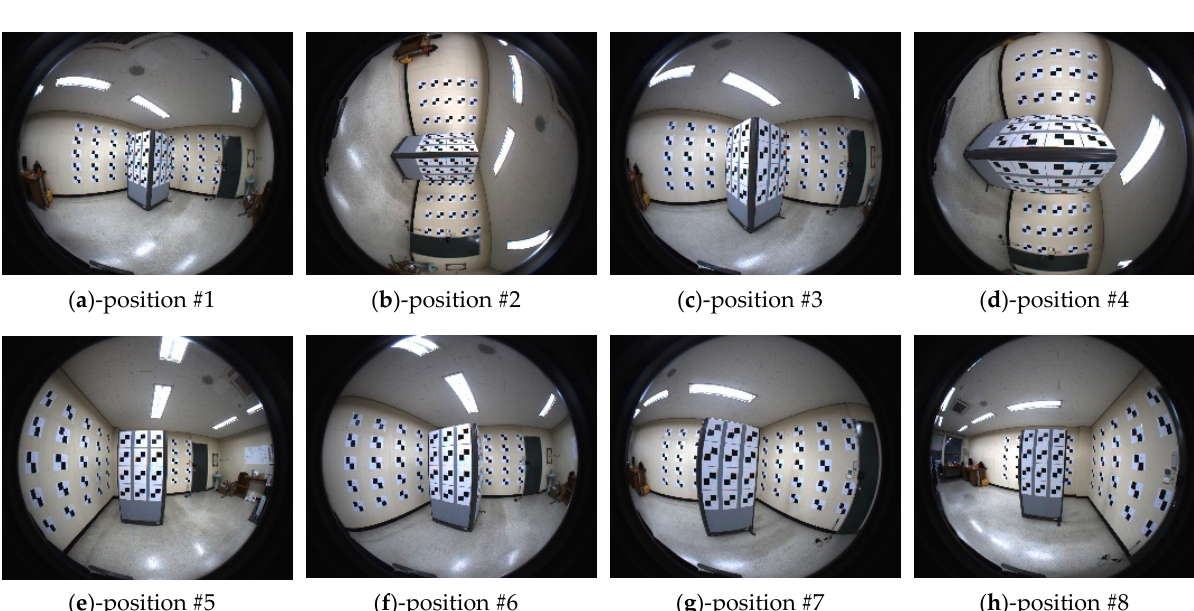
Figure 6. Images of camera 2 (equisolid angle).